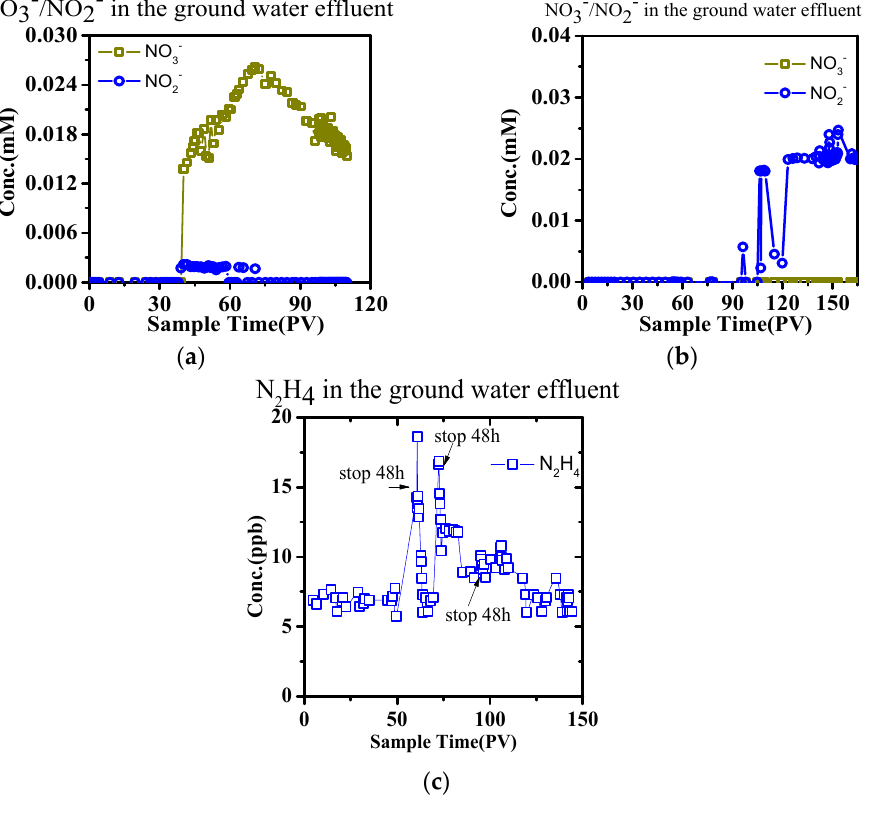
Figure 3. The kinetic curves of NO 3 − and NO 2 − in the ground-water effluent under aerobic conditions ( a ), anaerobic conditions ( b ), and N 2 H 4 in the effluent under anaerobic conditions ( c ).